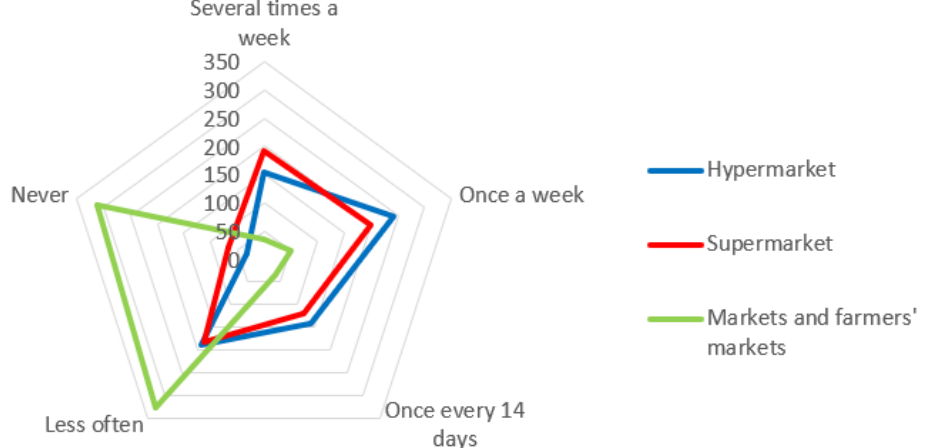
Figure 2. Radar chart, place of purchase of organic agriculture and food products and purchase frequency. Source: authors. Table 6. Contingency table, Hypermarkets & Respondent’s gender.